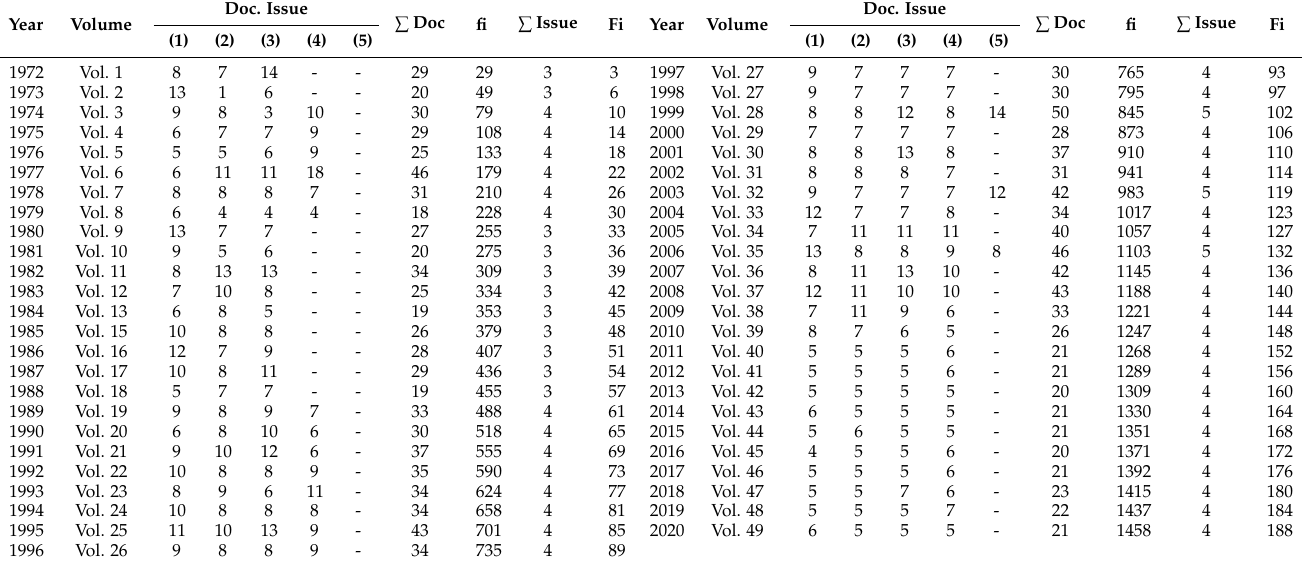
Table 1. Annual distribution of documents published in